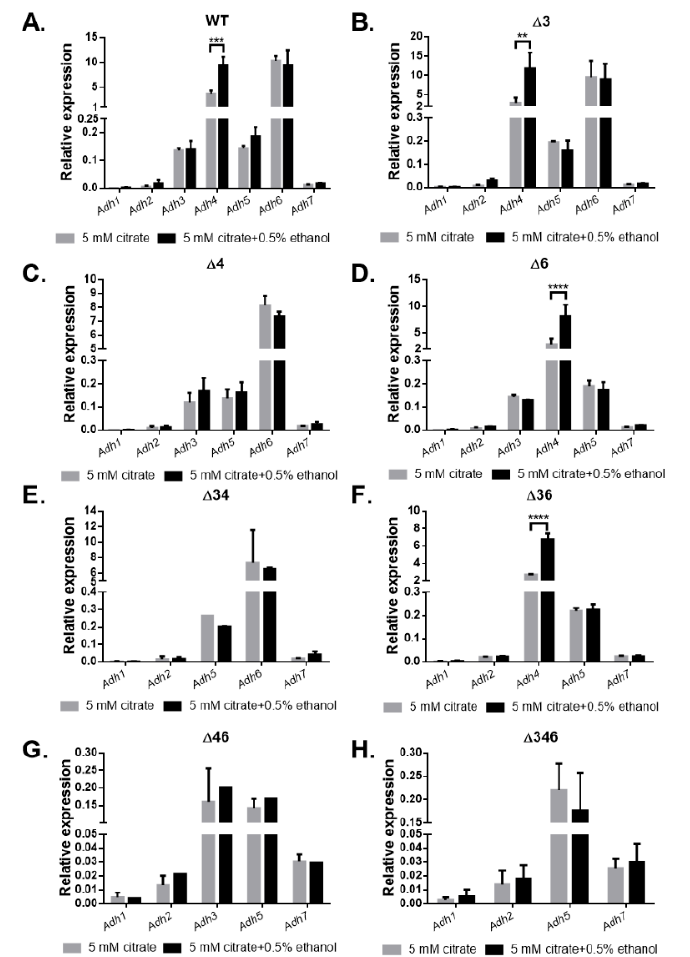
Figure 4. Relative gene expression of Adh genes in wild-type and mutant strains after culturing in medium with or without ethanol. The gyrase gene ( A4U85_RS04125 ) was used as a control to calculate relative expression levels. Comparison of relative gene expression for A. baumannii ATCC 19606 ( A ) wild-type; ( B ) Δ 3 single mutant; ( C ) Δ 4 single mutant; ( D ) Δ 6 single mutant; ( E ) Δ 34 double mutant; ( F ) Δ 36 double mutant; ( G ) Δ 46 double mutant; and ( H ) Δ 346 triple mutant strains cultured in M9 medium with 5 mM citrate (gray bar) or 5 mM citrate and 0.5% ethanol (black bar). Two-way ANOVA tests were conducted to assess statistical significance. ** p < 0.01; *** p < 0.001; **** p < 0.0001.